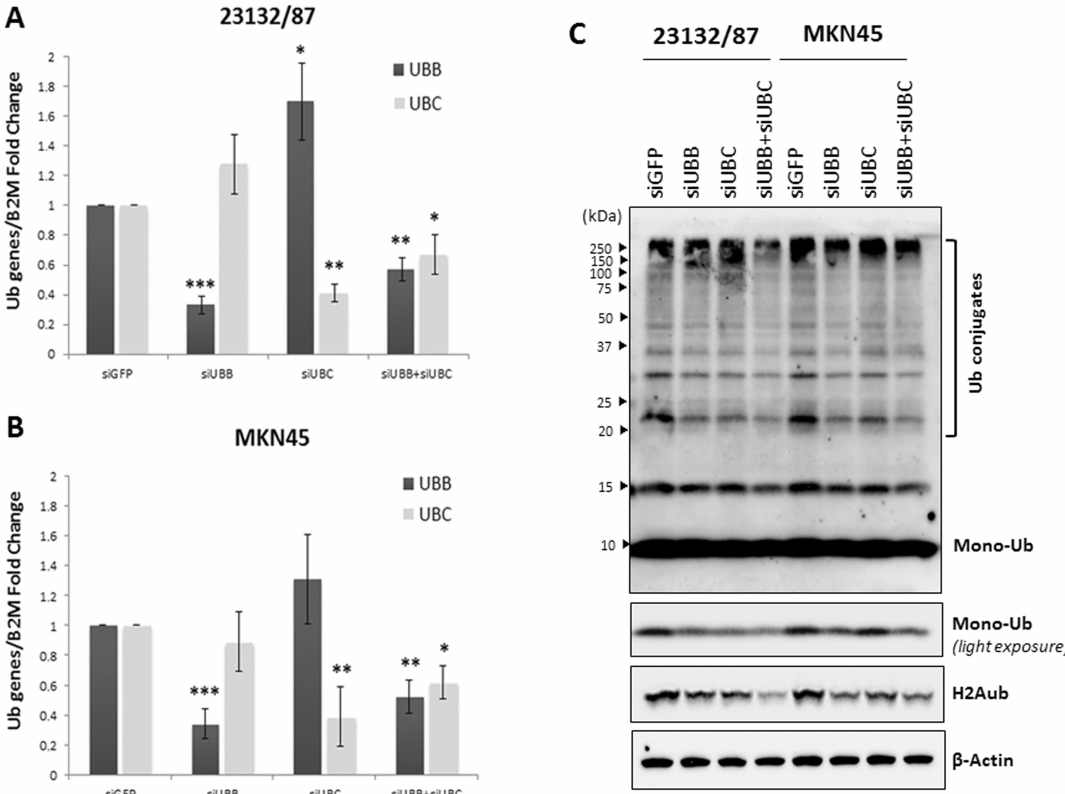
Figure 4. siRNA-mediated knockdown of UBB and UBC in 23132 / 87 and MKN45 cell lines. 23132 / 87 and MKN45 cells were transiently transfected with either control GFP or UBB , UBC or UBB + UBC siRNAs. At 48 h after transfection, the mRNA levels of UBB and UBC for 23132 / 87 ( A ) and MKN45 ( B ) were measured by real-time quantitative PCR, normalized to B2M mRNA and depicted as fold change compared with si GFP transfected cells, set as 1. Data are means ± SD ( n = 3); * p < 0.05, ** p < 0.01, *** p < 0.001. ( C ) Representative western immunoblots ( n = 2) of total protein lysates (5 µ g) of 23132 / 87 and MKN45 cells obtained 48 h after transfection with si GFP (control), si UBB , si UBC and si UBB + si UBC . The samples were loaded and probed with anti-Ub antibody to detect the conjugated and mono-Ub pools (the latter were analyzed using the light exposure image). Blots were reprobed with anti-H2Aub and anti- β -Actin antibody, used as a loading control. Brackets indicate Ub conjugates. Arrowheads on the left indicate the molecular weight